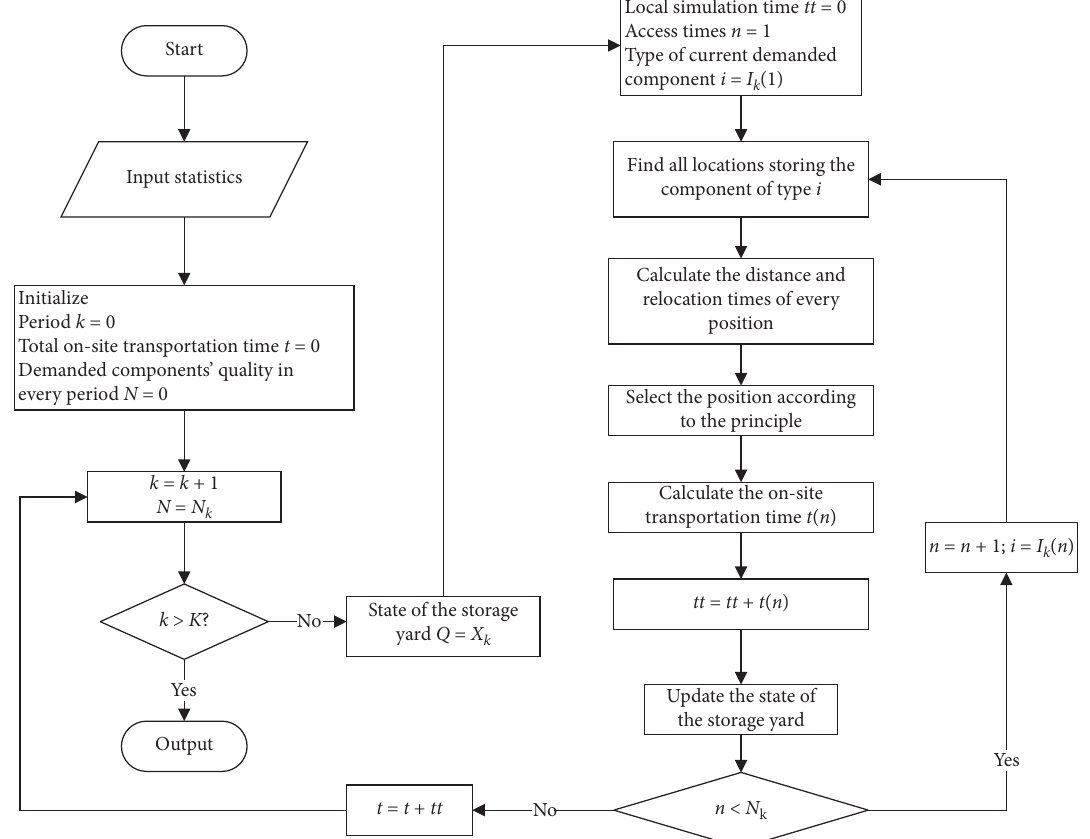
Figure 7: Flowchart for calculating on-site transportation time using